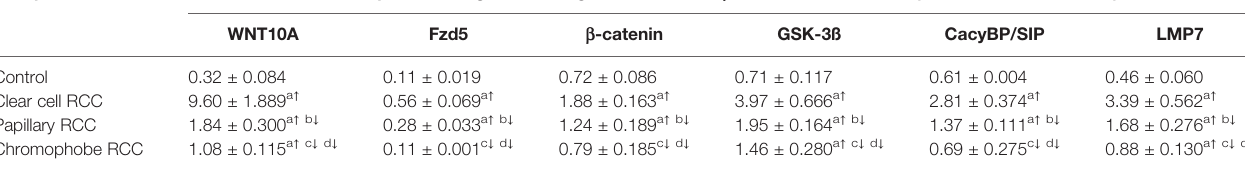
TABLE 3 | The expression of genes coding WNT10A, Fzd5, b -catenin, GSK-3ß, CacyBP/SIP, LMP7 in clear cell RCC, papillary RCC, chromophobe RCC and non- malignant renal tissue (mean ± SE). Group of Patients The expression of genes coding WNT10A, Fzd5, b -catenin, GSK-3ß, CacyBP/SIP, LMP7 in kidney